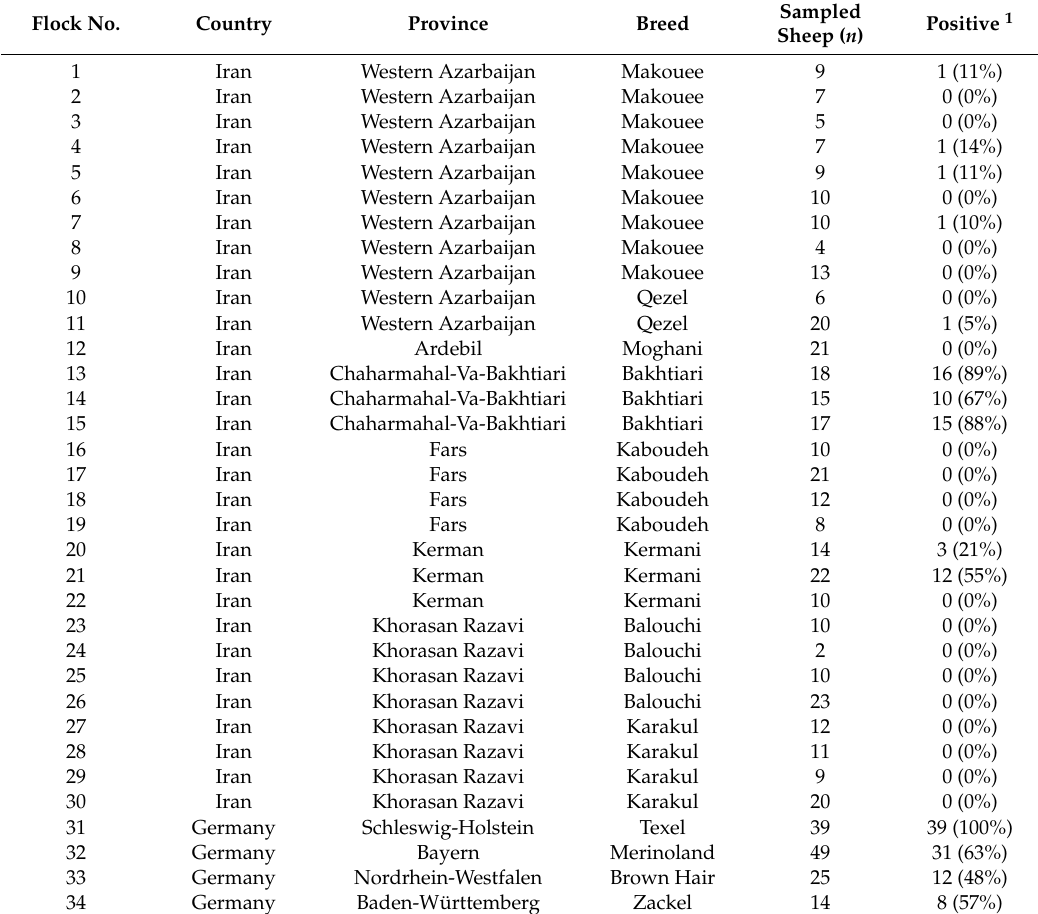
Table 1. Small ruminant lentivirus (SRLV) infection status in sampled sheep flocks of Iran and Germany. Flock